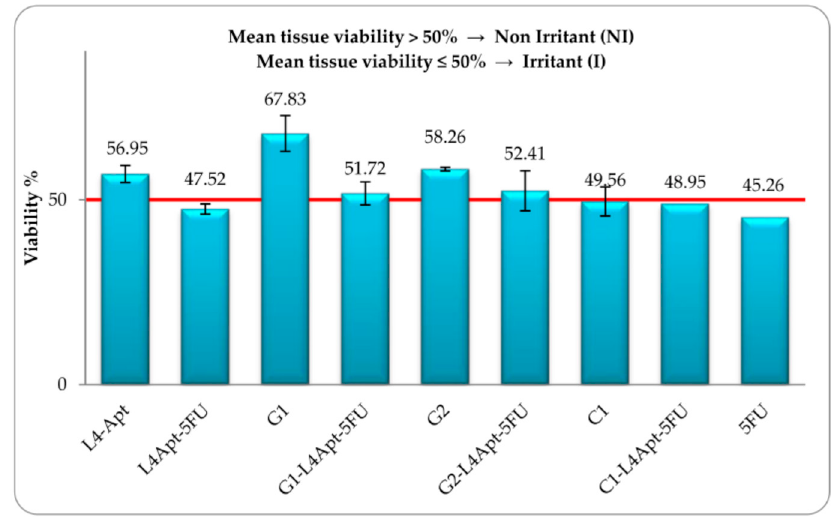
Figure 5. The in vitro cell viabilities of the different formulations in SkinEthic™ RHE tissues [107].